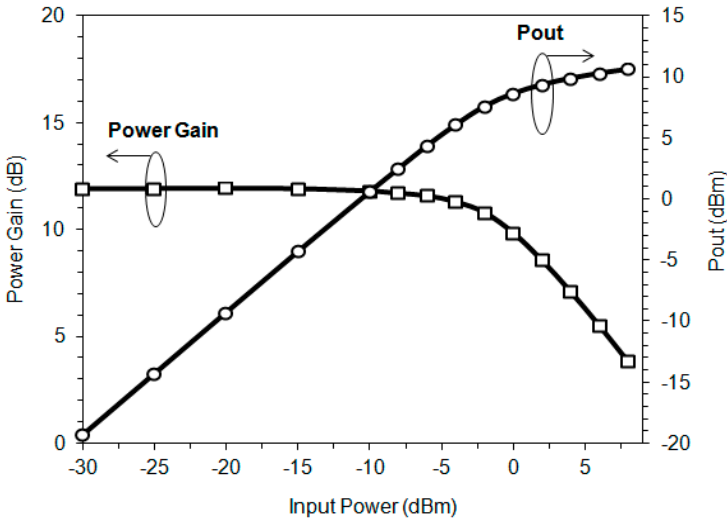
Figure 13. Measurement results of the power gain and pout of the proposed PA IC versus the input power.